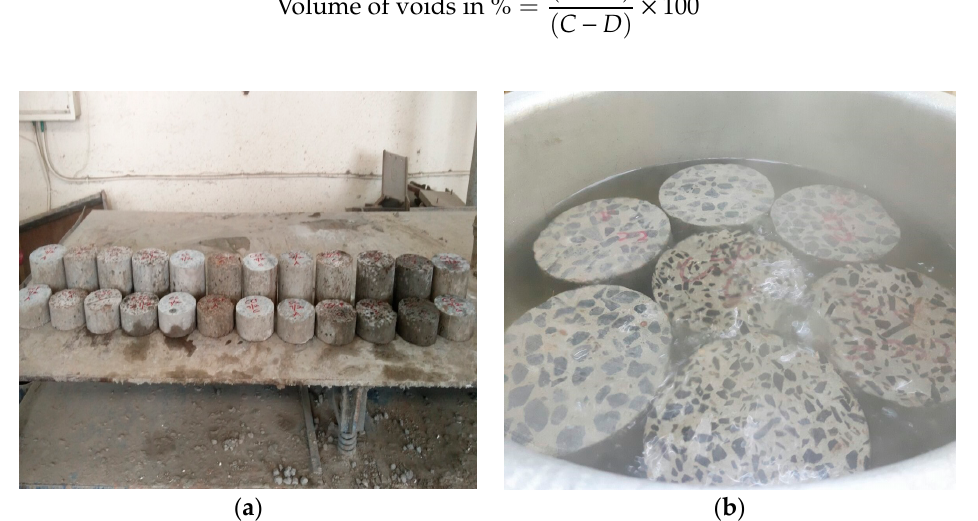
Figure 2. ( a ) Center core cut specimens ( b ) specimens under boiling.